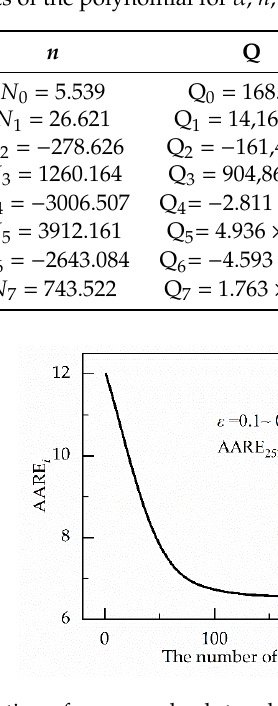
i with iterations.